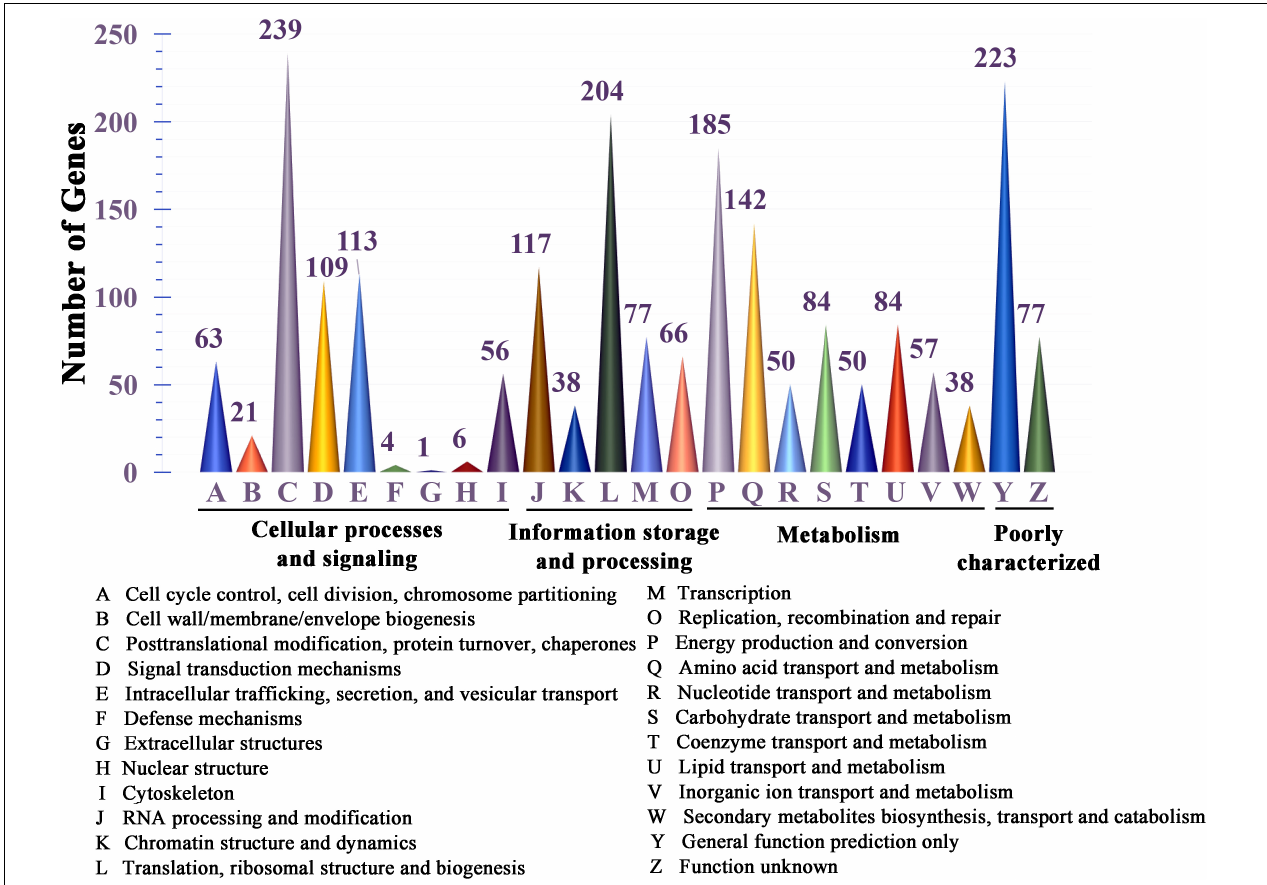
FIGURE 3 | KOG functional classification of proteins in the S. sanghuang Kangneng